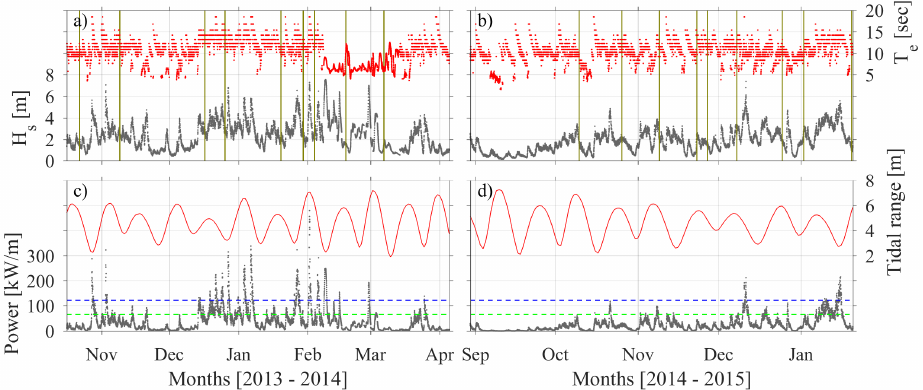
Figure 2. Measured wave conditions for the 2013–2014 winter in the left column of figures and the 2014–2015 winter in the right column of figures. The significant wave height (metres) and energy period (seconds) are presented in ( a , b ). ( c , d ) show the total wave power in kiloWatt per wave crest length and tidal range in metres. The black lines correspond to the left-hand vertical axes and the red lines follow the right-hand vertical axes. In ( a , b ) the vertical green lines represent dates for the presented video-derived bathymetries. The horizontal dashed-lines in ( c , d ) represent the 99% (blue) and 95% (green) quantile exceedance